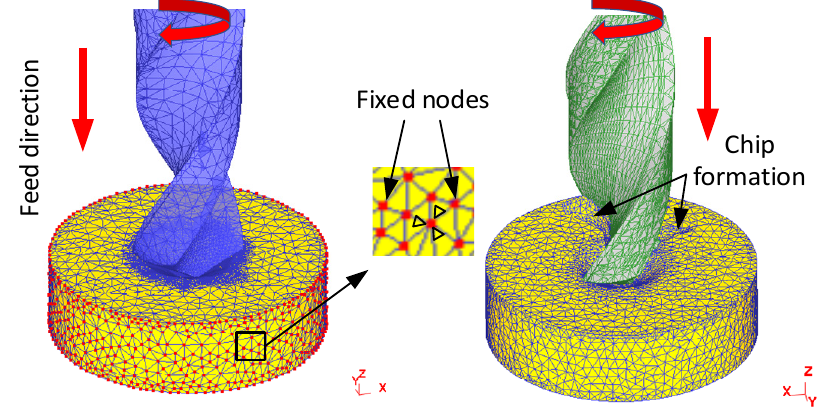
Figure 2. Constraints of the simulation.